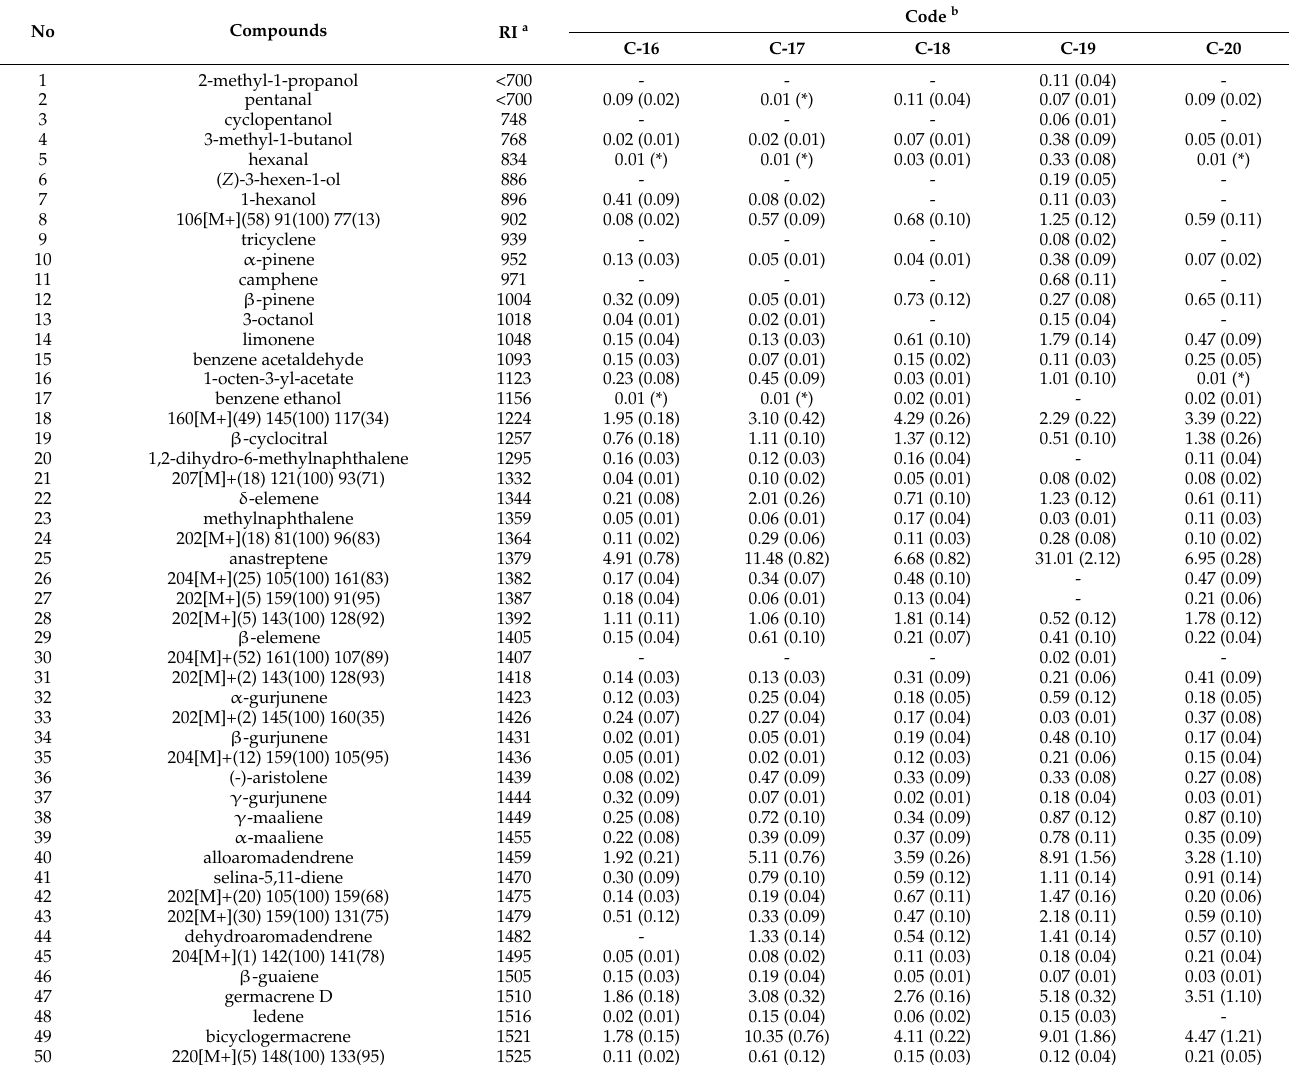
Table 5. Volatile compounds detected in the samples